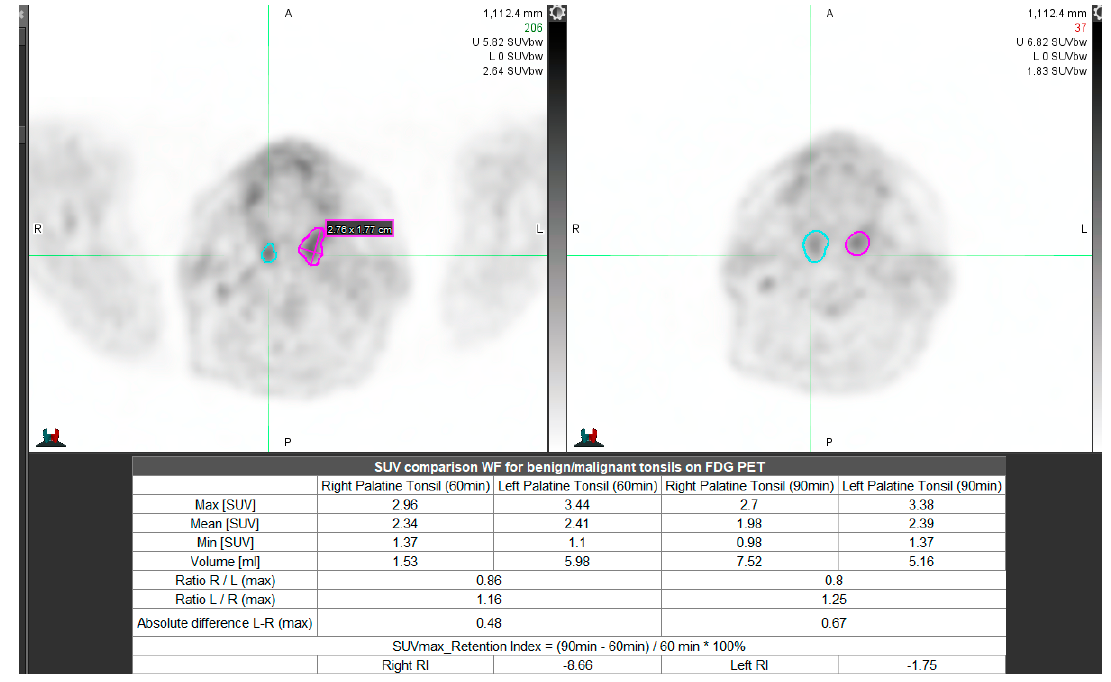
Figure 1. Unilateral inflammation (MiM 7.0 software). Description: Left upper image—initial, right upper scan—delayed scanning.